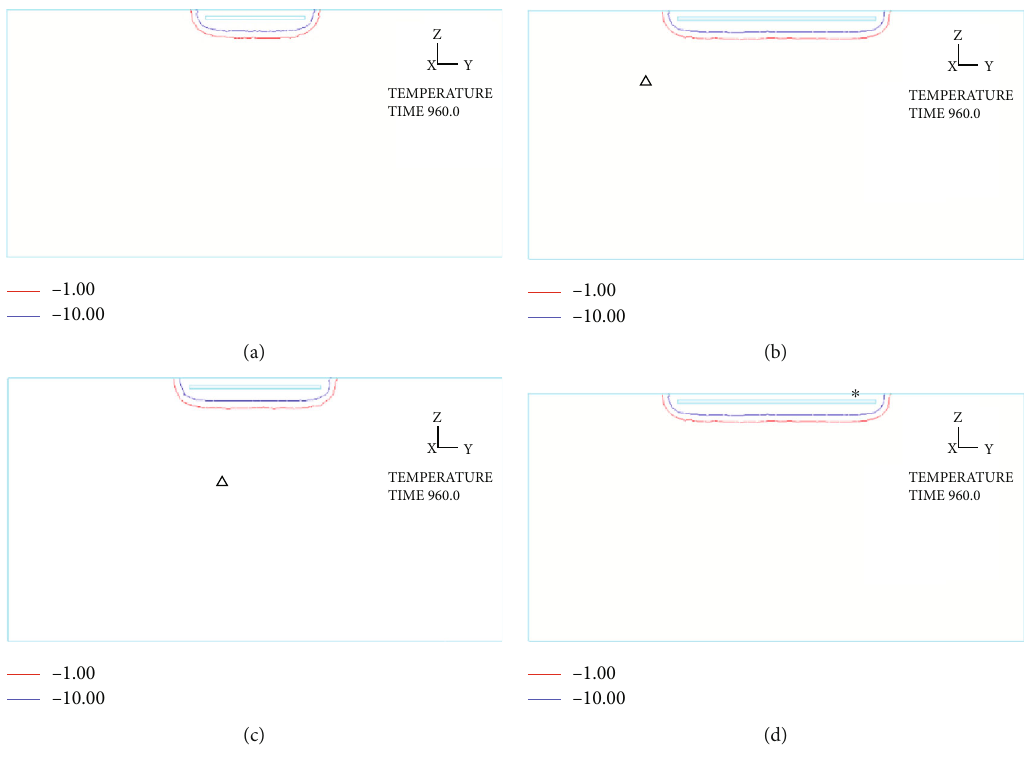
Figure 6: Schematic of the freezing